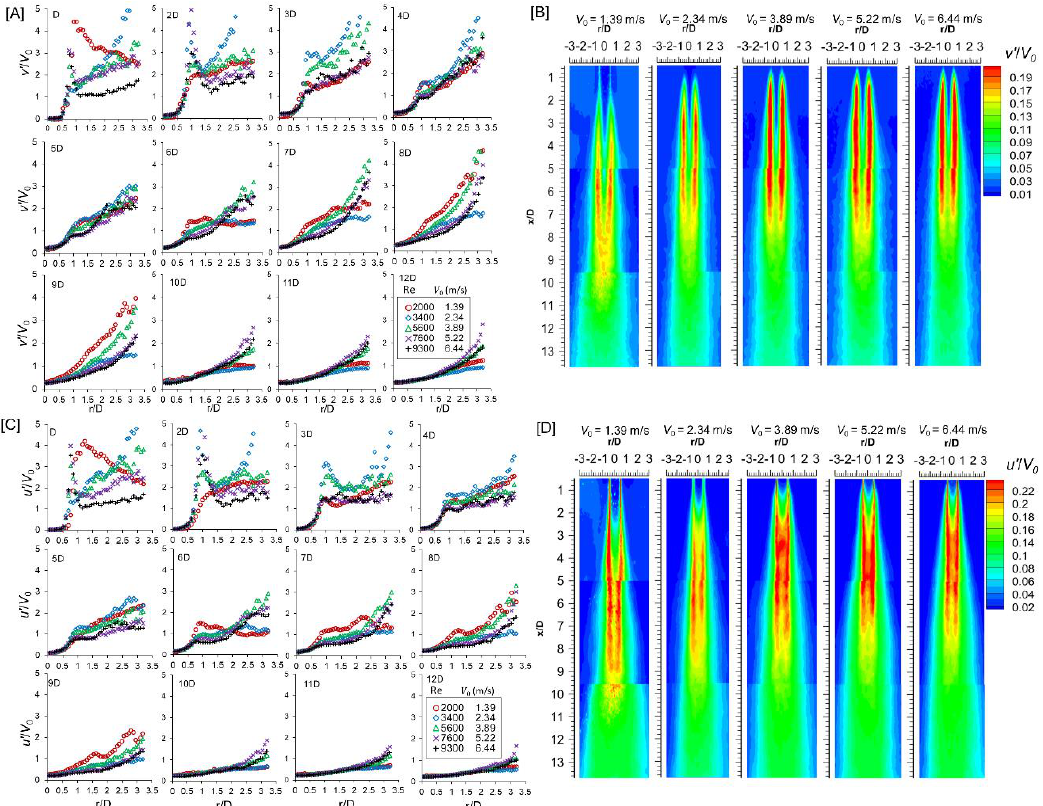
Figure 7. Lateral distribution of the root mean square (r.m.s) fluctuations of the turbulent velocity component (left; ( A ) is streamwise component and ( C ) spanwise component) and the respective contour plots (right; ( B ) is streamwise component and ( D ) spanwise component).